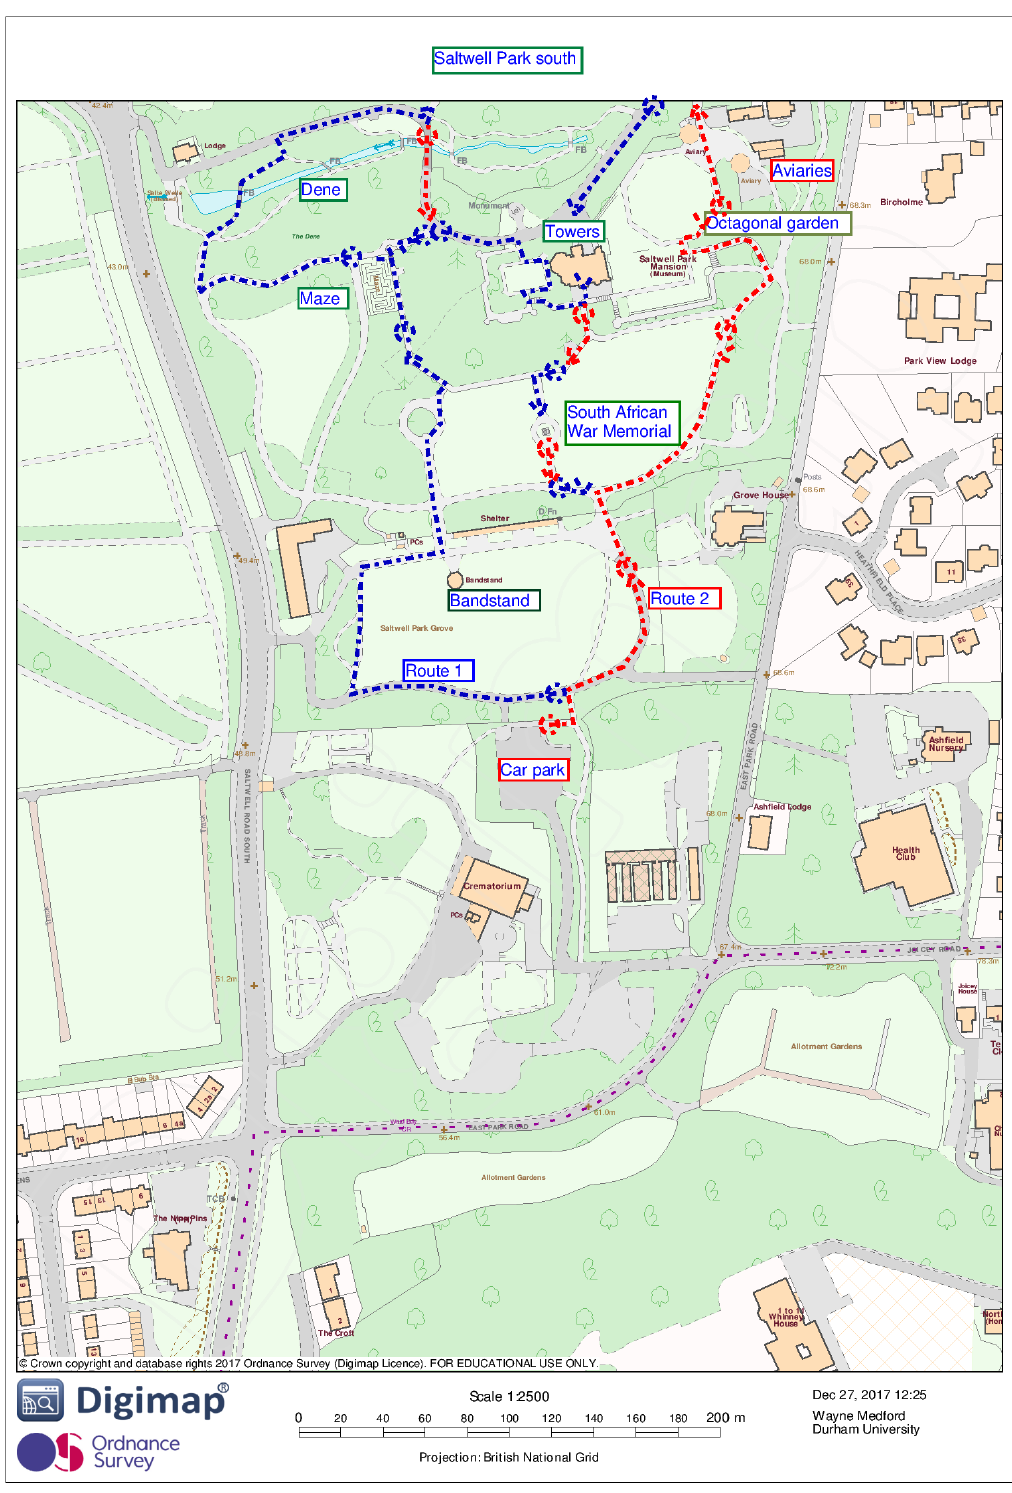
Figure 4. Walking routes through the southern half of Saltwell Park.